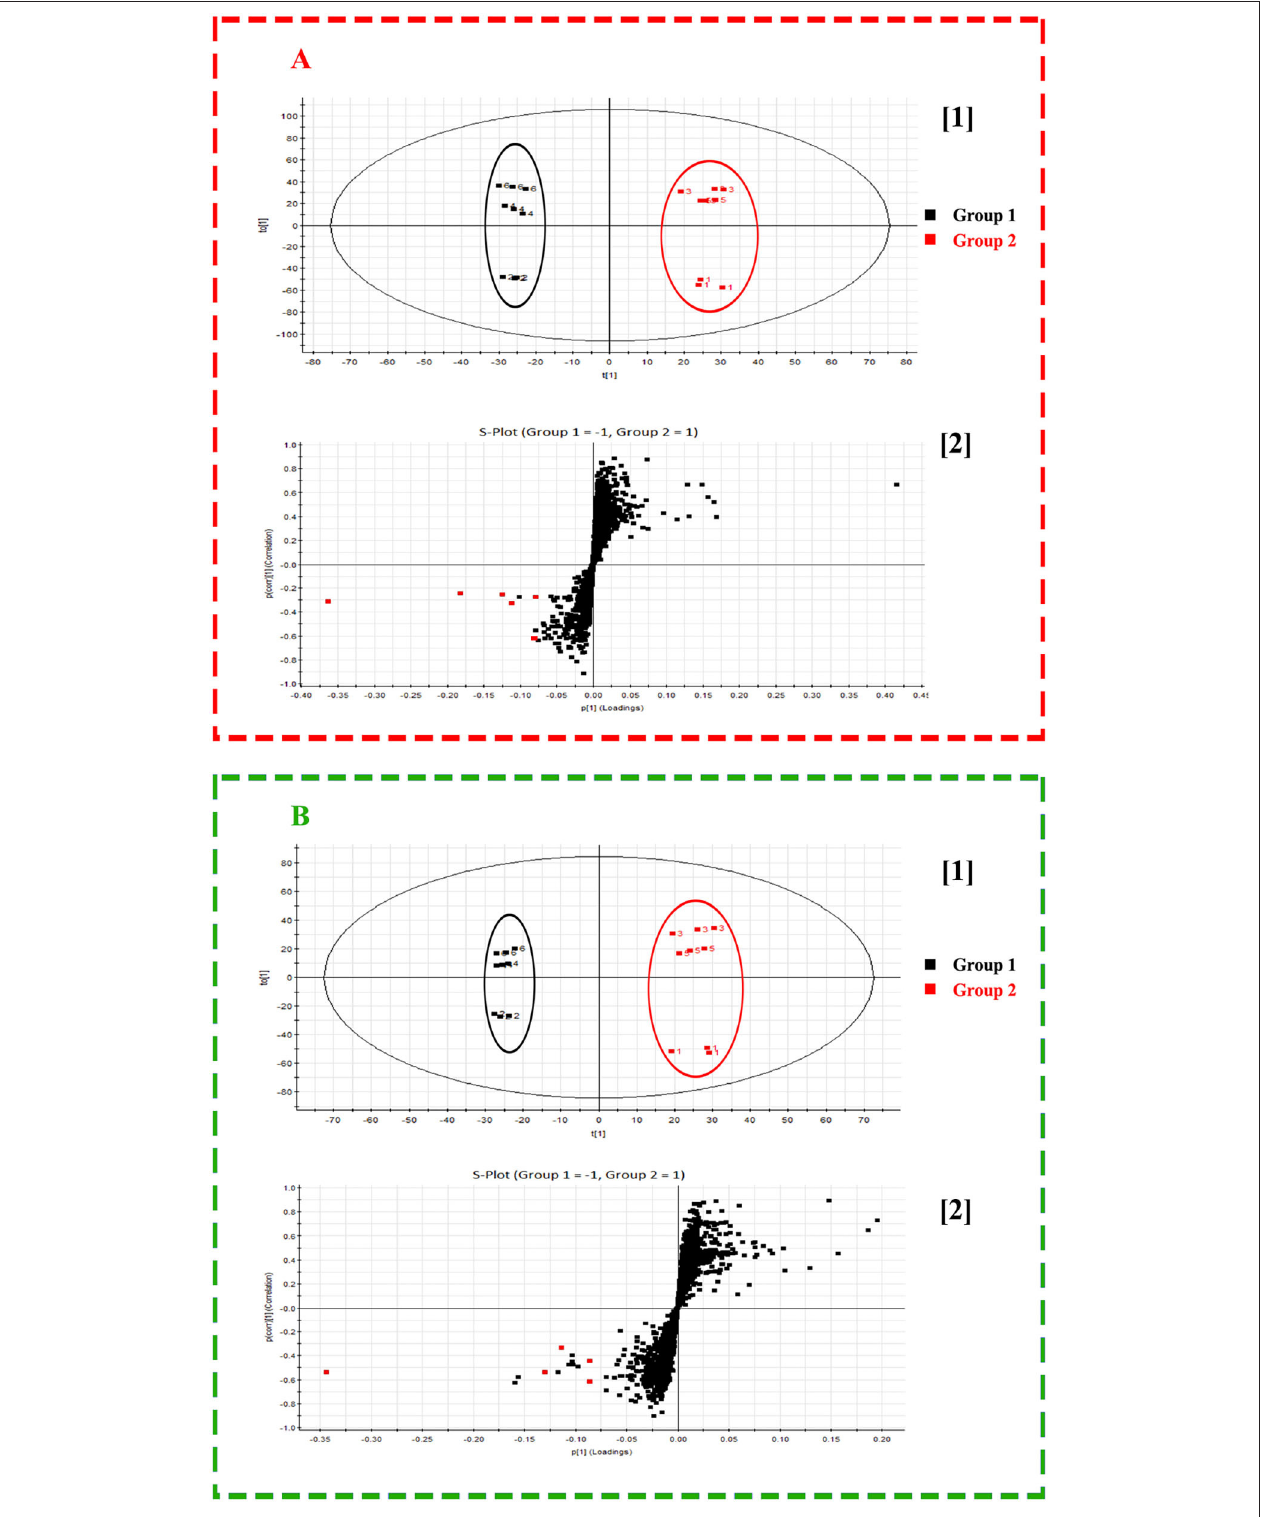
FIGURE 4 | Score plot ([1]) and S-plot ([2]) obtained from orthogonal partial least squares discrimination analysis (OPLS-DA) results of Radix Isatidis with quality character code 1–6 based on desorption electrospray ionization and quadrupole-time-of-flight (DESI-Q-TOF) mass spectrometry imaging (MSI) in the spectral ranges of m / z 50–1,200 under positive (A) and negative (B) ionization modes. The potential quality-associated markers for Isatidis Radix were tagged to red dots.